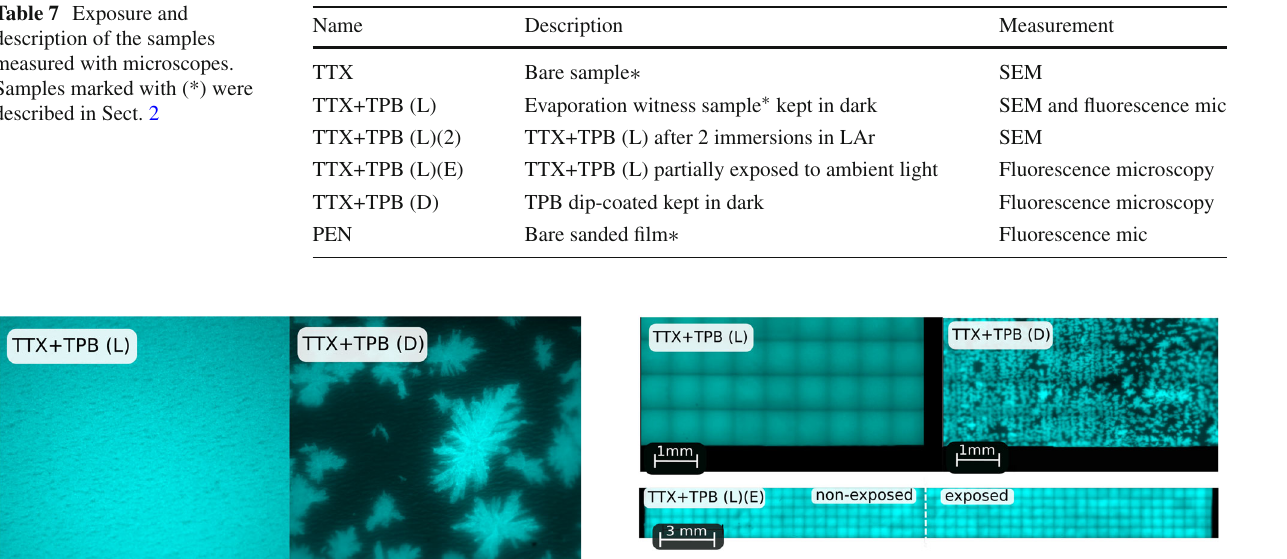
Fig. 19 Top: fluorescence microscopy images of TTX+TPB (L) and TTX+TPB (dip-coated). Images are composed of multiple scans (’tiles’).Thescalebarsare1mm.Bottom:AlongtilescanofTTX+TPB (L). The left half of it had been exposed to ambient light for two weeks. A shaded line in the middle identifies the border between exposed and non-exposed sample. The scale bar is 3mm